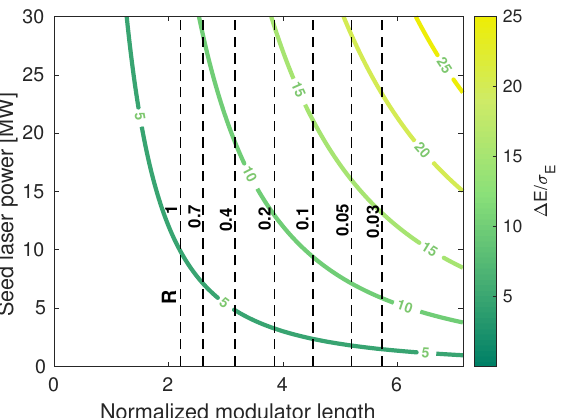
Figure 6. The color bar indicates the energy modulation achieved for combinations of seed laser peak powers ( P in ) and modulator lengths ( L mod ) and is calculated with Equation (3). The horizontal axis shows the normalized modulator length to the gain length ( L mod / L g ). The vertical dashed lines show the reflectivity R required for equilibrium between amplification and losses for different normalized modulator lengths, and is calculated with Equation